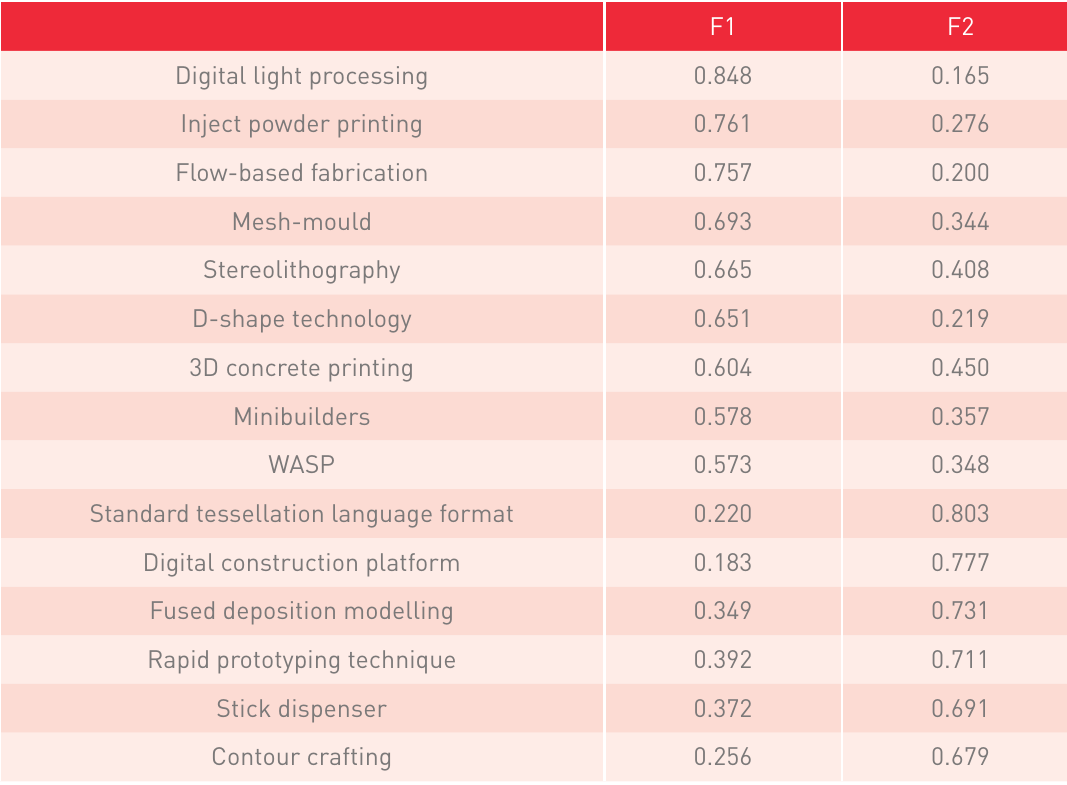
Table 10. Awareness of 3D printing Rotated Component